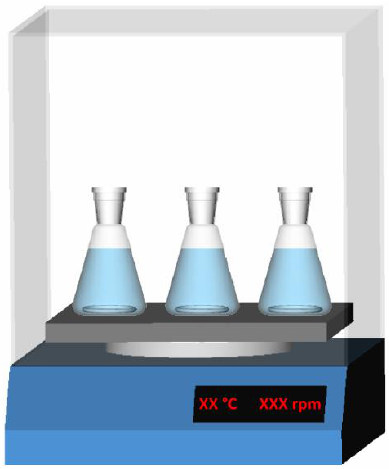
Figure 2. Schematic view of a shake-flask setup used for determining drug release of IVRs.